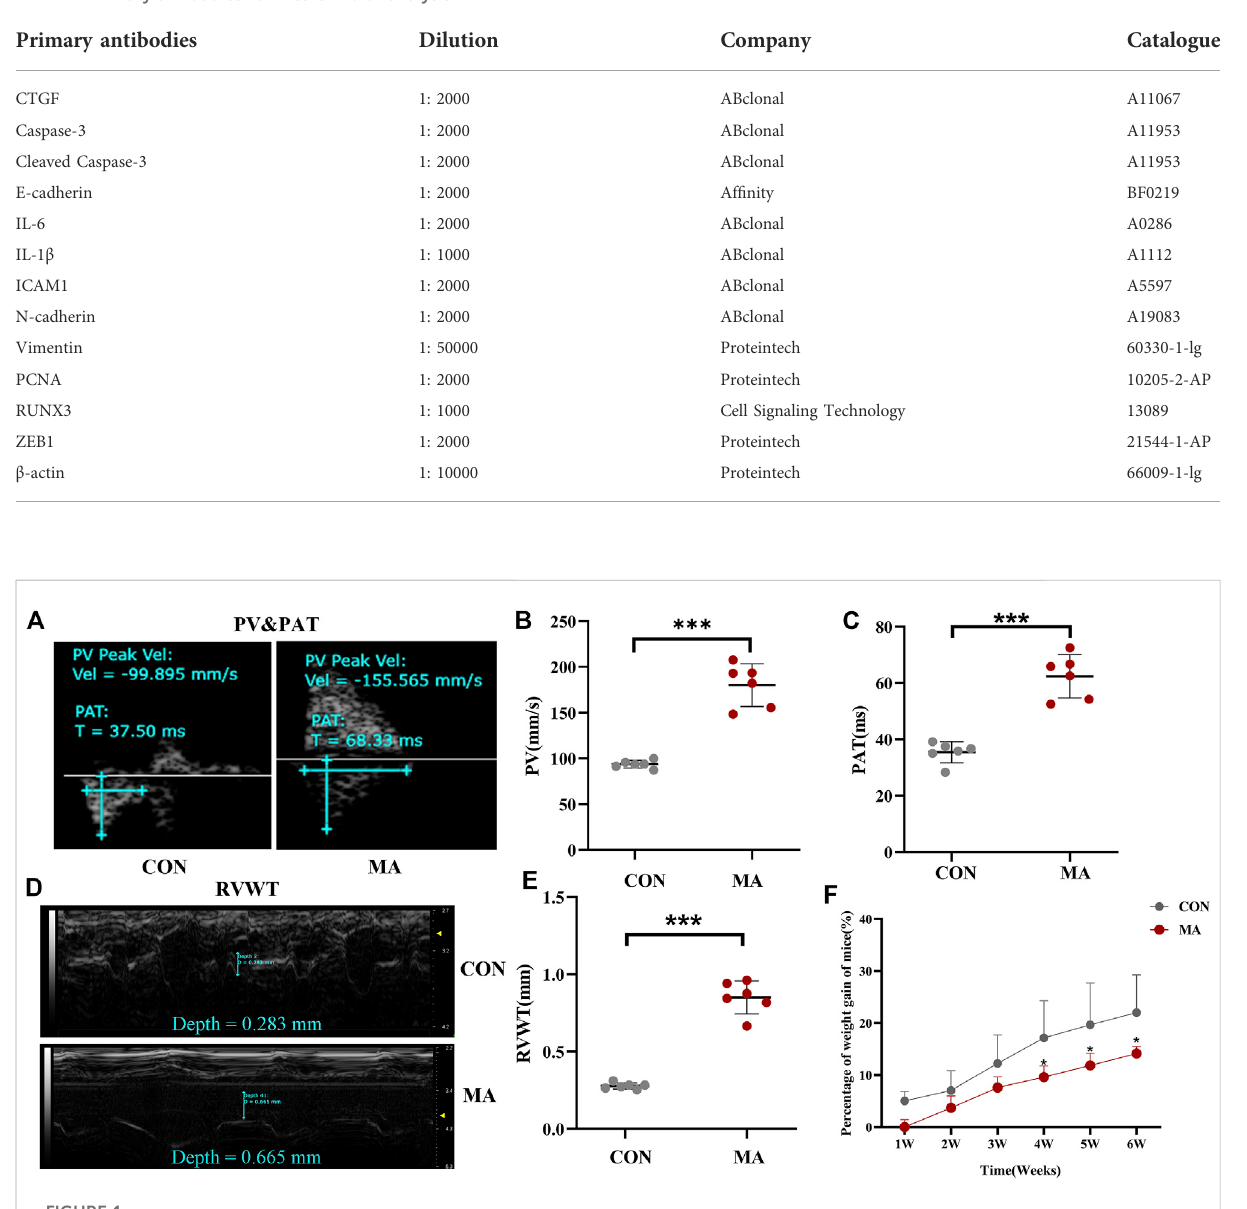
TABLE 2 Primary antibodies for western blot analysis.